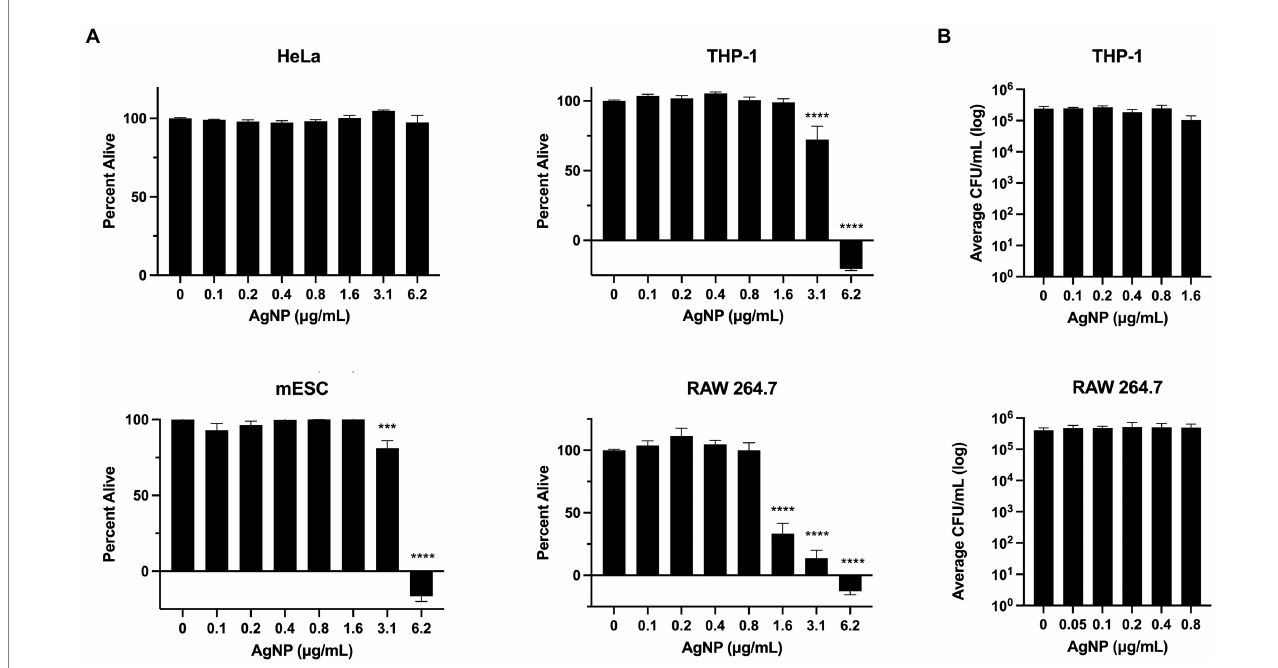
FIGURE 4 AgNP cytotoxicity assessed using different cell types. (A) The assessment of AgNP cytotoxicity to HeLa, pre-treated for 24 h, mESC, pre-treated for 18 h, THP-1, pre-treated for 24 h, and RAW 264.7 cells, pre-treated for 4 h, reveals cell type-specificity. (B) The effect of AgNPs on bacterial uptake by phagocytic macrophages at non-cytotoxic concentrations. Error bars represent SEM. Percent alive values were normalized to the control. Statistical significance was calculated using a one-way analysis of variance (ANOVA) followed by multiple comparison Dunnett’s post-hoc test (*** p < 0.0005, **** p < 0.0001). Error bars represent SEM. Data represent three independent experiments with three internal replicates per run.